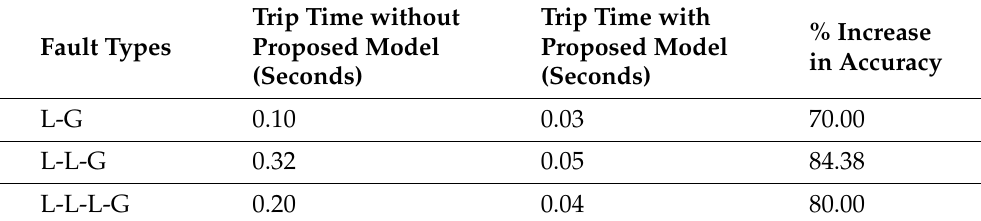
Table 8. Percentage accuracy of the proposed model at bus